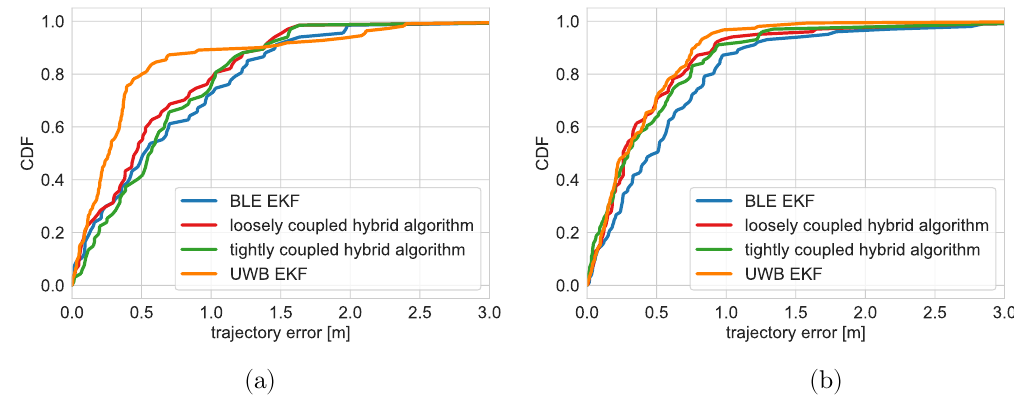
Figure 14. Empirical Cumulative Distribution Function of localization trajectory error (smallest distance from reference trajectory) for: ( a ) path 1, ( b ) path